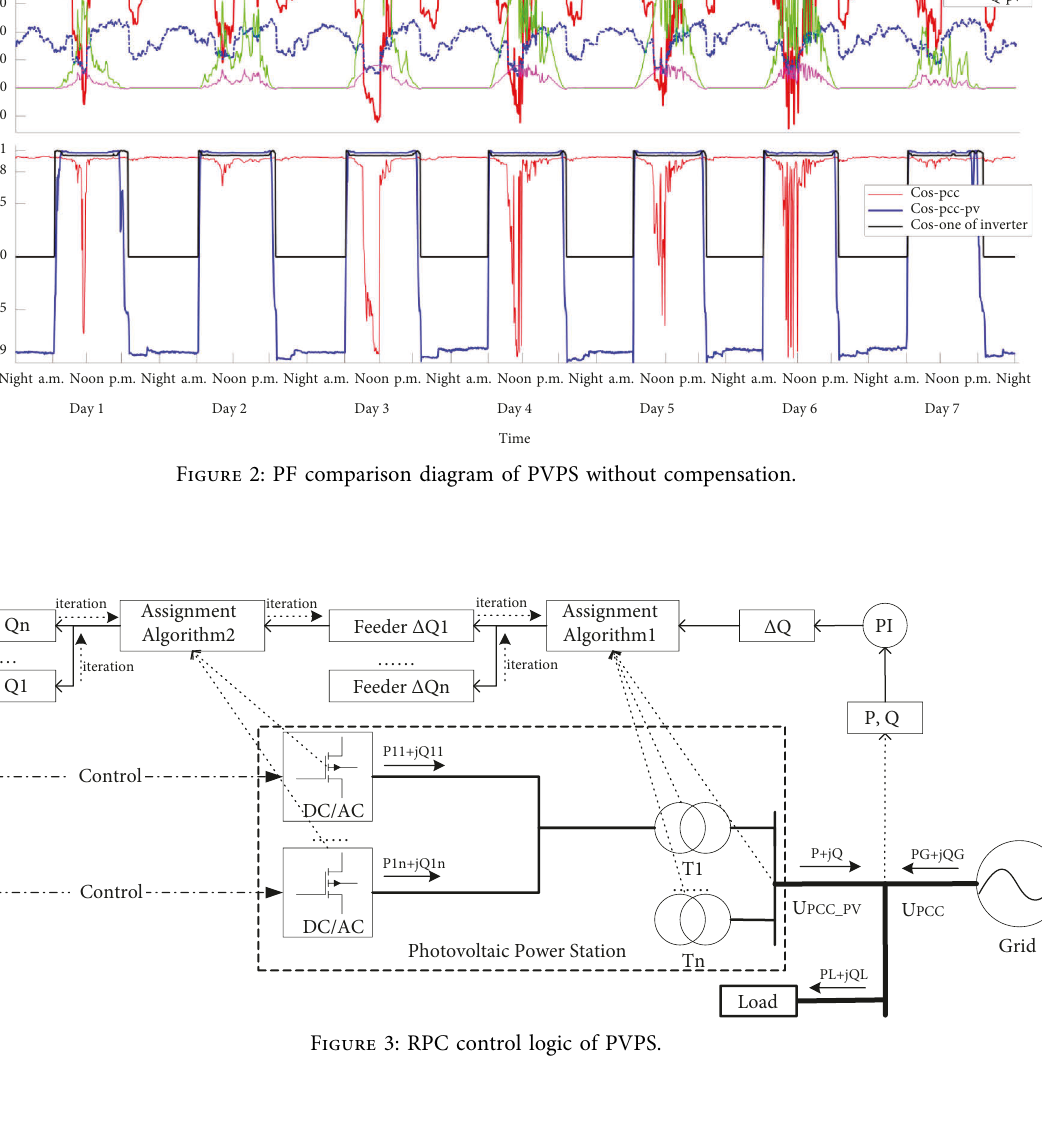
Table 2: Ratio distribute algorithm of static capacity. Algorithm 1: Ratio distribute algorithm